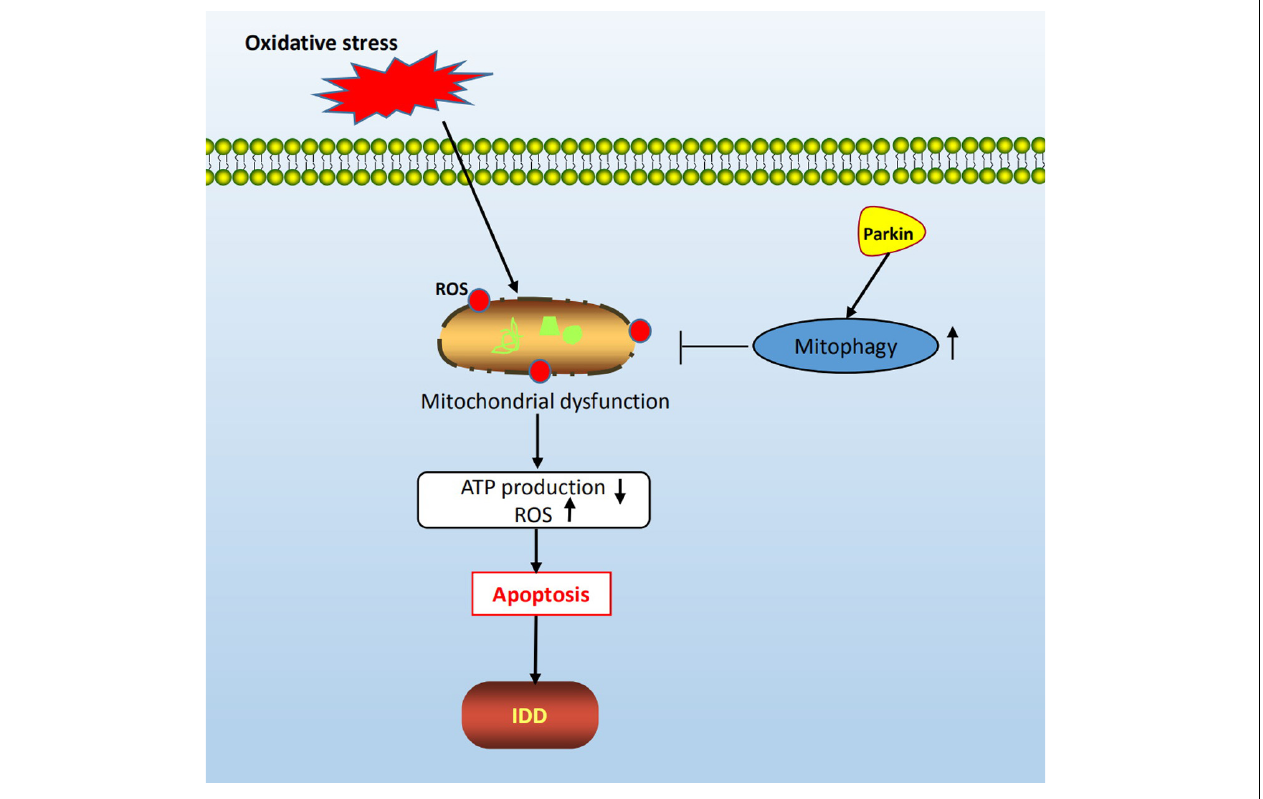
FIGURE 7 | Schematic diagram of mechanisms shows the protective role of mitophagy in rat NP cells under oxidative